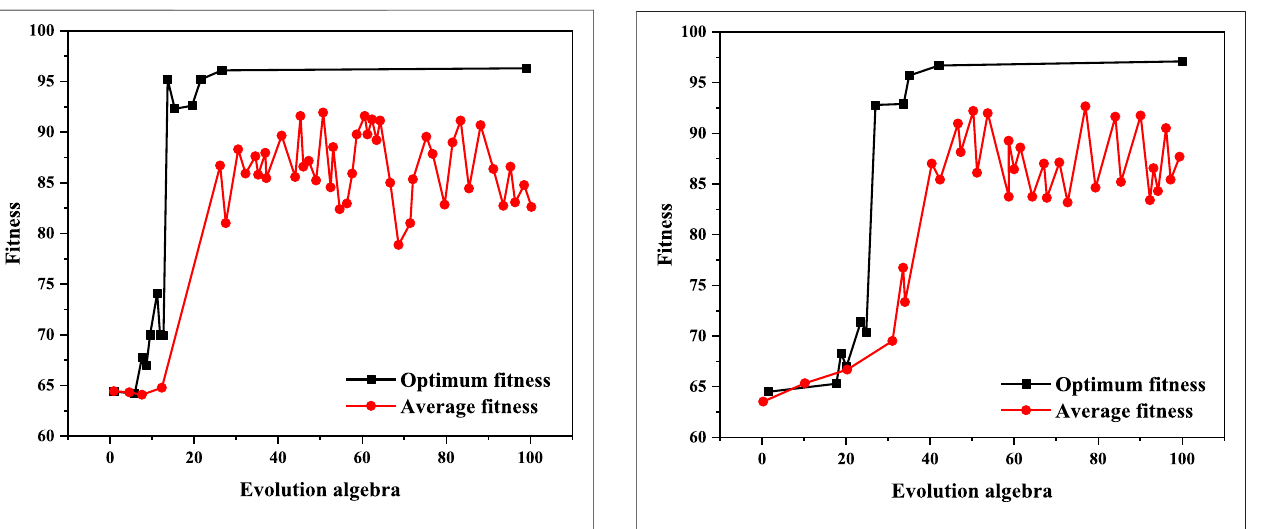
FIGURE 7 | Fitness curve of improved genetic